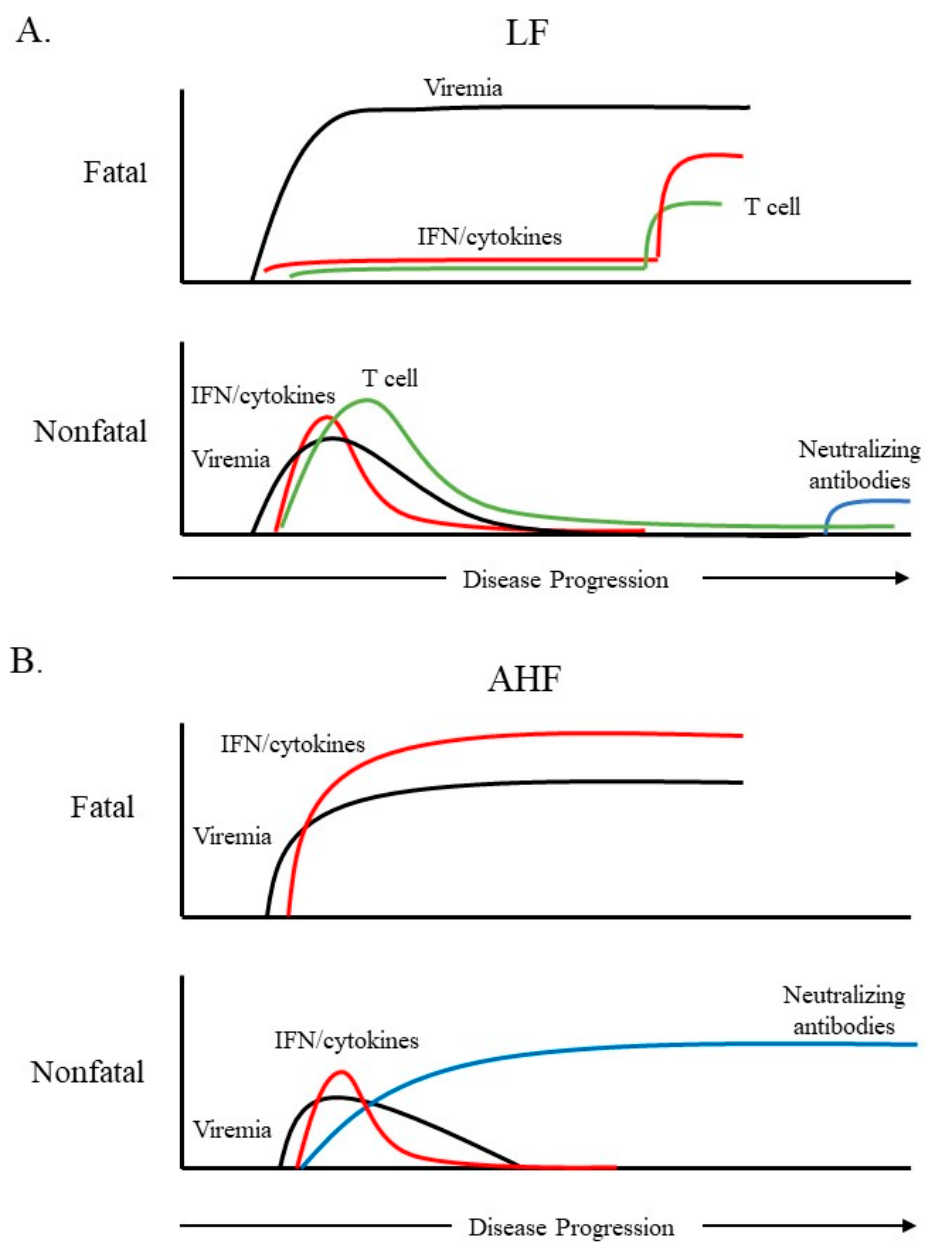
Figure 1. A schematic diagram of the immune response over the course of fatal or nonfatal cases of Lassa fever (LF) or Argentine hemorrhagic fever (AHF). ( A ). Fatal cases of LF are characterized by a lack of interferon (IFN) and pro-inflammatory cytokines throughout most of the infection. A cytokine spike late in infection has been reported in some fatal LF cases. Survival and Lassa virus (LASV) clearance are correlated with a robust T-cell response as well as higher IFN levels early in infection. Neutralizing antibodies are not detectable until late in convalescence. ( B ). Extremely high levels of serum IFN/pro-inflammatory cytokines are observed in fatal cases of AHF. Survival is correlated with lower levels of IFN/cytokines, which decrease as viremia subsides. AHF survivors often develop high neutralizing antibody titers during the acute phase of